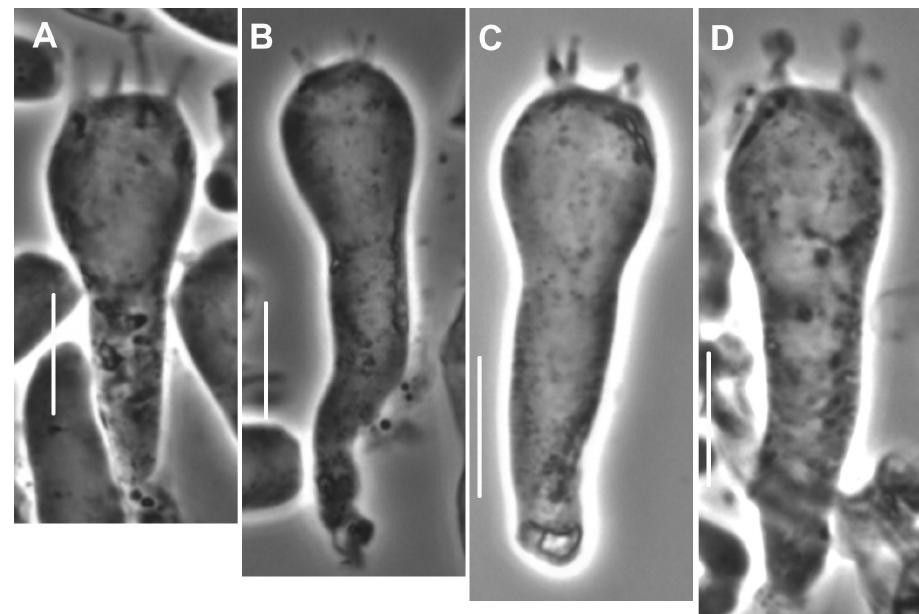
Figure 45. Mycetinis olidus . Basidia. Note heterogeneous contents. Standard bars = 10 µm. DED 4529 (TENN